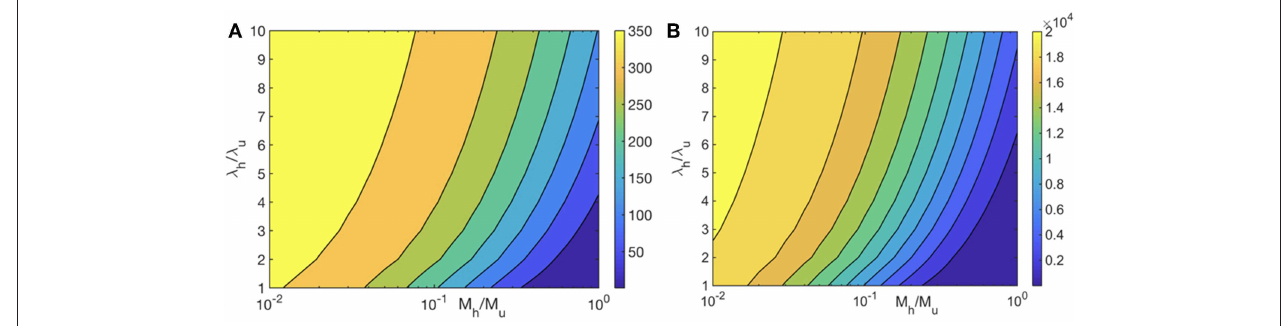
) as a function of the ratio of their fusion ( λ h /λ u ) and mitophagy u